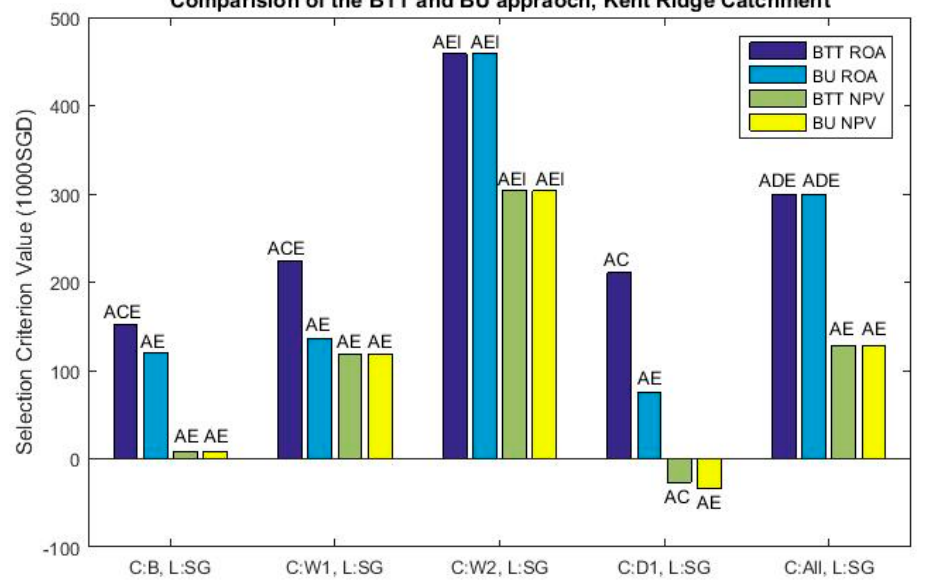
Figure 6. Pathways selected for the Sustainable Grey landuse under different climate (C) scenarios, by means of the BTT and BU approach using the Real Options Value and Net Present Value as selection criterions for the Kent Ridge Catchment.